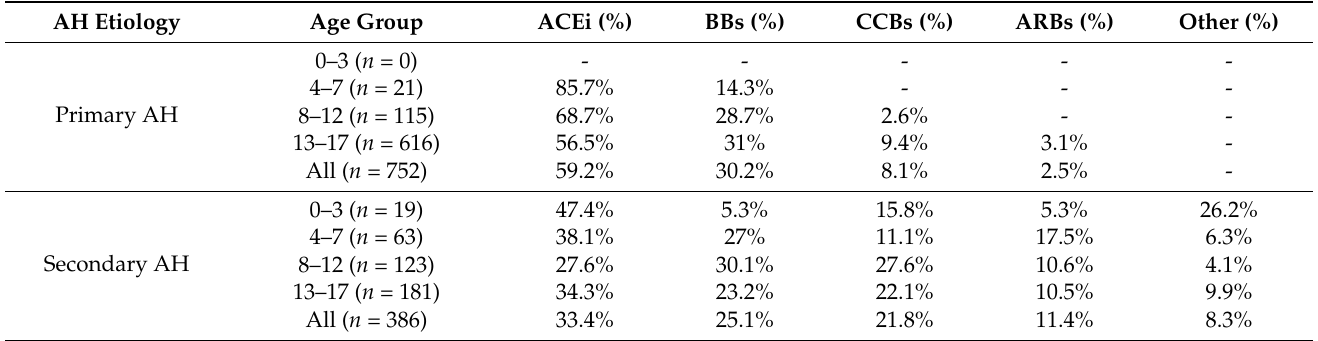
Table 1. Rates of different class antihypertensive medication prescription by age and AH etiology.